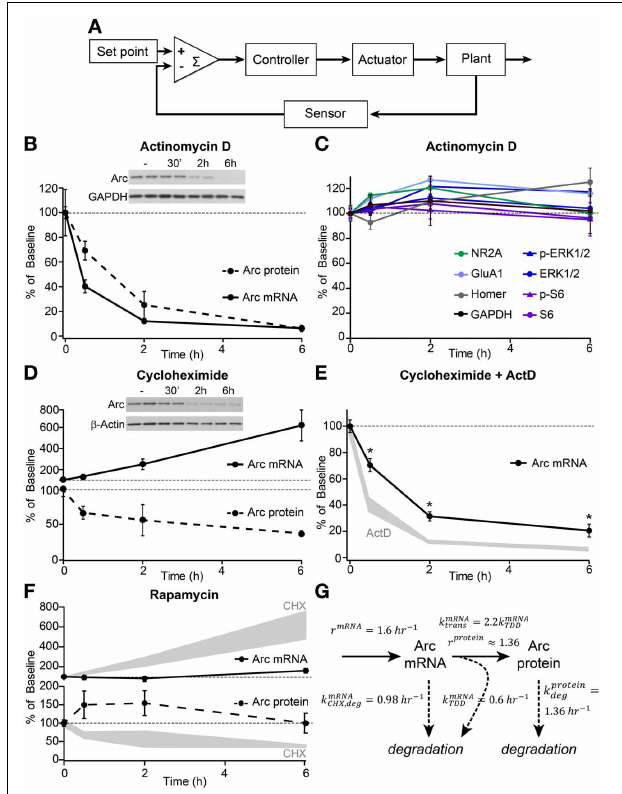
FIGURE 1 | Arc mRNA and protein exhibit high basal turnover rates and translation-dependent mRNA decay. (A) Schematic depicting the elements of a homeostatic negative feedback system. (B) Decay curves of Arc mRNA (measured by quantitative RT-PCR, solid line) and protein (determined by western blotting, dashed line) from dissociated hippocampal cultures following treatment with 8 μ M actinomycin D (ActD) for the indicated times in hours. (C) Western blotting of the synaptic and signaling proteins indicated in the legend revealed no effects of 6h treatment with actinomycin D on total protein levels or phosphorylation state. (D) Time courses of Arc mRNA accumulation (solid line) and protein degradation (dashed line) following treatment with 10 μ M cycloheximide (CHX). (E) Decay curves of Arc mRNA levels following combined treatment with 8 μ M ActD and 10 μ M CHX (black line) versus ActD alone (shaded gray, replotted from B ). ∗ Indicates significant difference ( p < 0 . 05) from ActD alone. (F) Treatment with 50nM rapamycin had no significant effect on Arc mRNA (top panel, solid line) or Arc protein (bottom panel, dashed line) levels. For comparison, Arc mRNA and protein levels following CHX treatment are replotted from (D) in shaded gray. (G) Diagram detailing experimentally-derived time constants for the production and degradation of Arc mRNA and protein. See methods for the derivation of these values. All data are from 2–3 independent experiments and are represented as mean ± SEM. Dotted lines at 100% indicate baseline